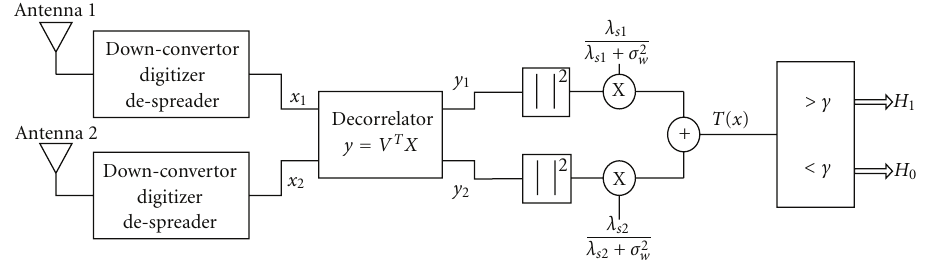
Figure 2: LRT detector scheme for a two-antenna diversity